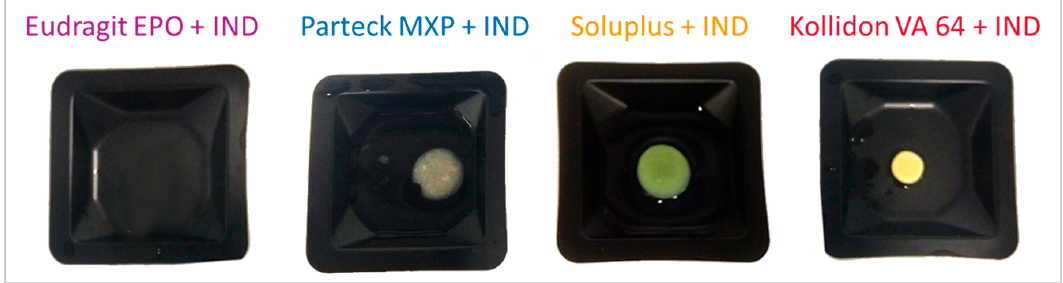
Figure 10. VCM discs after 6 h of dissolution on weighing boats.